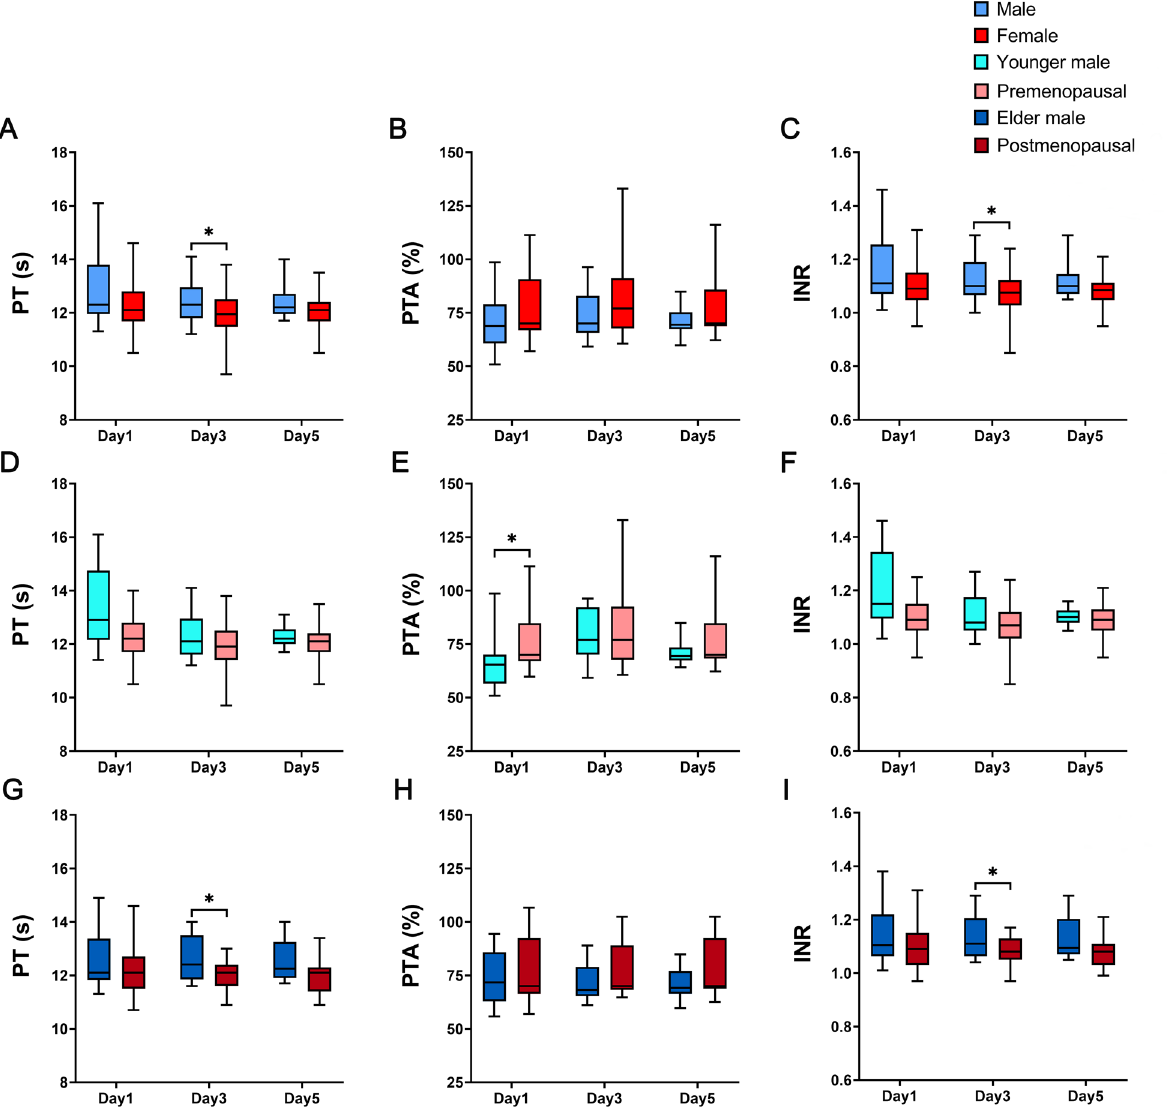
Figure 1. Comparison of coagulation function. ( A ) PT between male group and female group. ( B ) PTA between male group and female group. ( C ) INR between male group and female group. ( D ) PT between younger male group and premenopausal group. ( E ) PTA between younger male group and premenopausal group. ( F ) INR between younger male group and premenopausal group. ( G ) PT between elder male group and postmenopausal group. ( H ) PTA between elder male group and postmenopausal group. ( I ) INR between elder male group and postmenopausal group (* P < 0.05, ** P < 0.01, *** P <